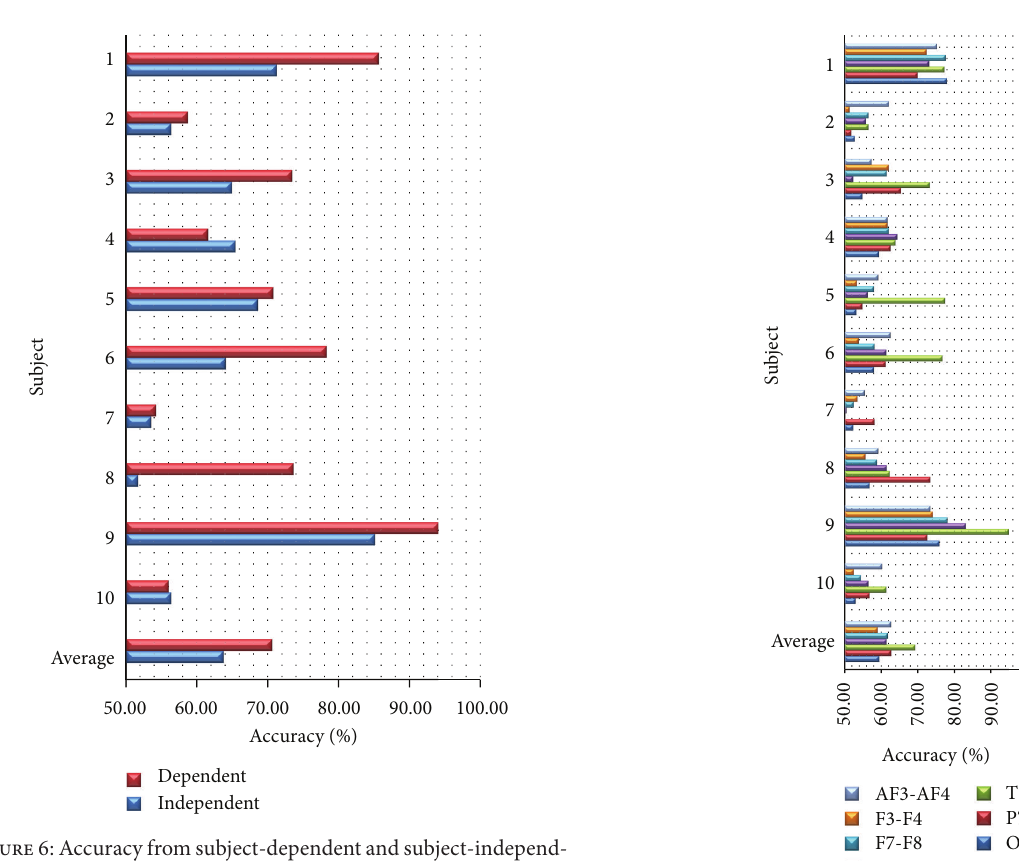
Figure 6: Accuracy from subject-dependent and subject-independ- ent models.